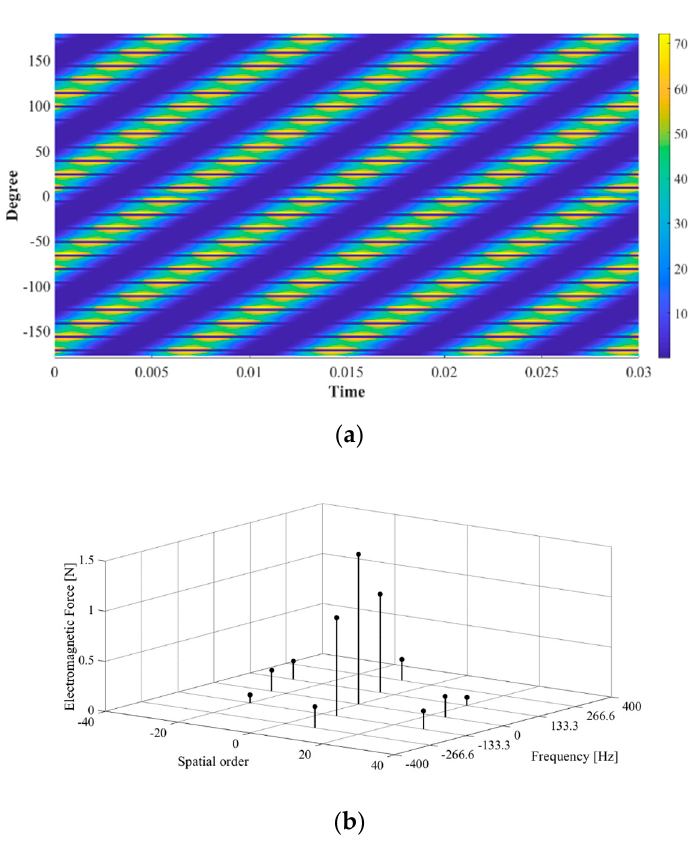
Figure 4. Characteristic of Electromagnetic Force ( a , b ).